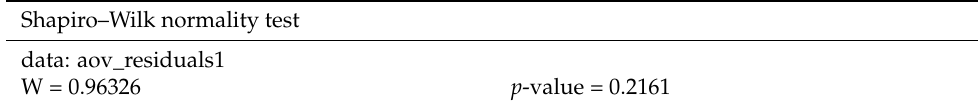
Table 9. Shapiro–Wilk test for flexure strength for NEXTDENT material.